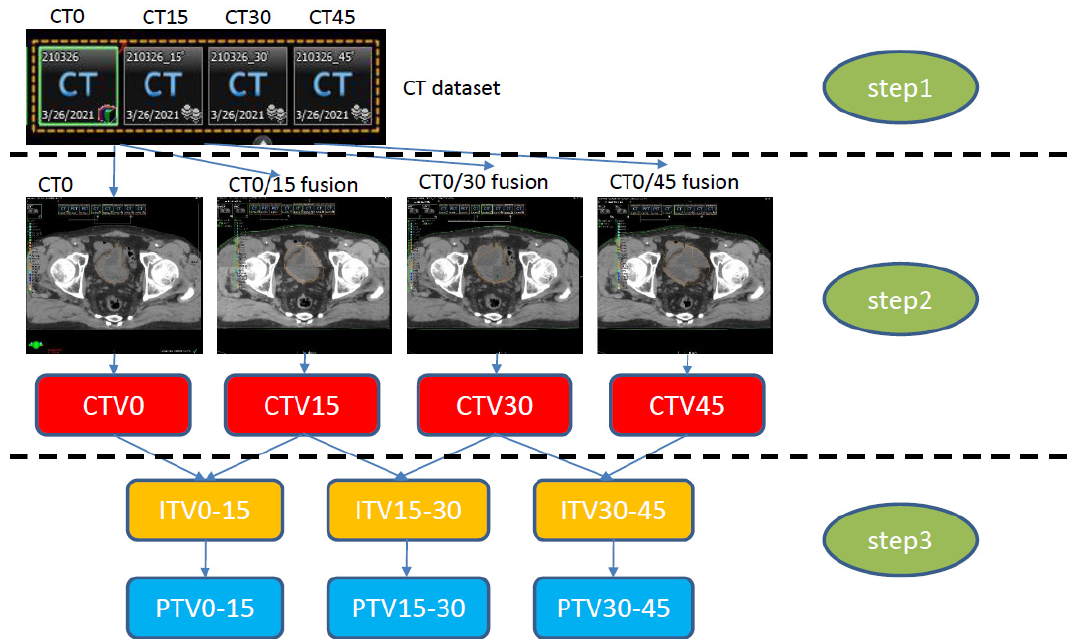
Figure 1. Study workflow. Step 1: CT simulation with an empty bladder (CT0). Sequential CT simulation at 15 min intervals (CT15, CT30, CT45) to construct the CT dataset. Step 2: Four CTV gener-